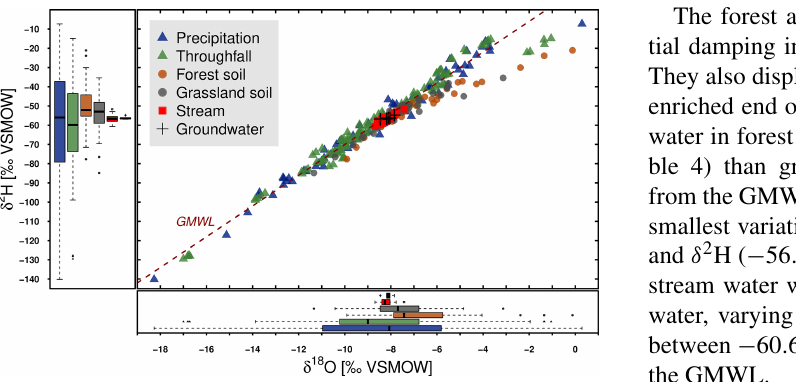
Figure 3. Dual-isotope plot of DMC precipitation, throughfall, for- est and grassland soil bulk water samples, as well as stream water and